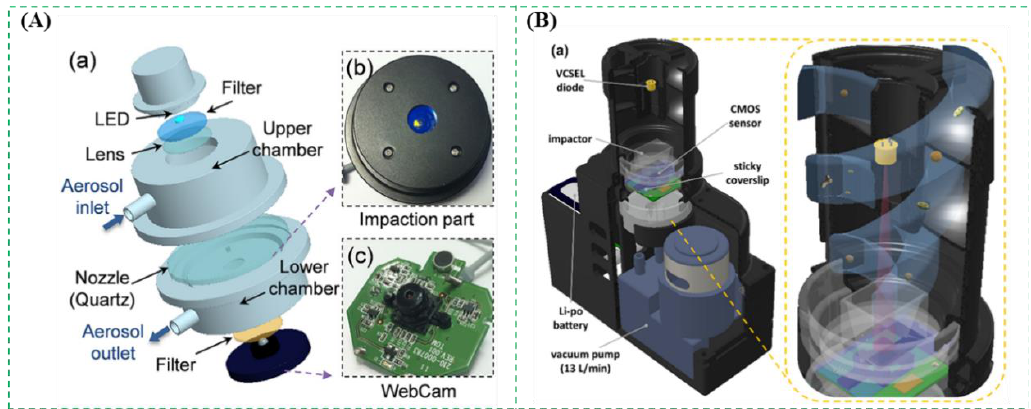
Figure 4. ( A ) The impactor for collection of the bioaerosols containing Escherichia coli . Reprinted with permission from ref.